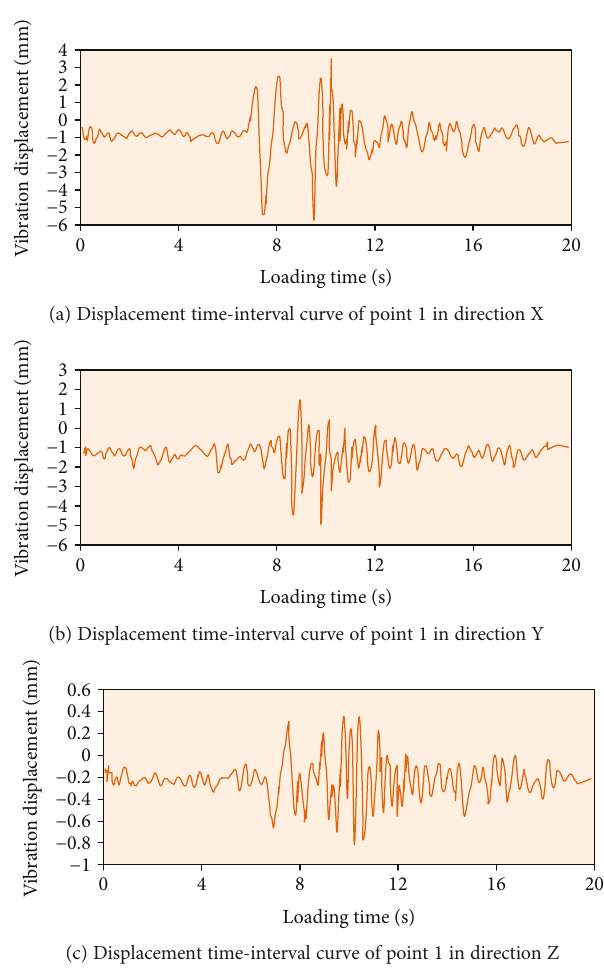
Figure 12: Displacement time-interval curves of point 1 in directions X, Y, and Z.